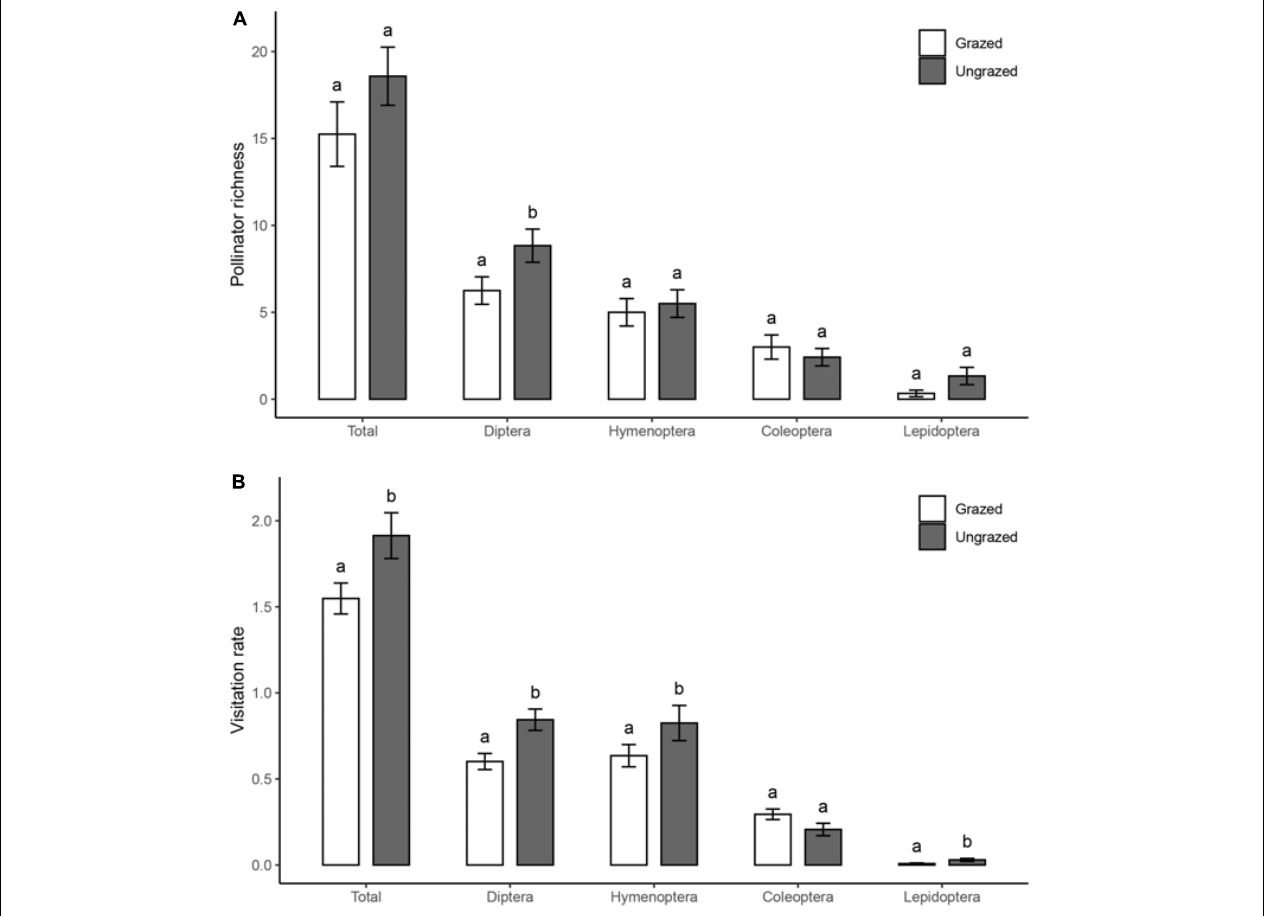
FIGURE 1 | (A) Number of total and of each order pollinator species ( n = 24 networks) in grazed and ungrazed habitats. (B) Visitation rate from total and of each order pollinators (based on data of the individual observation of each plant species in each network, n = 1,414). Bar plots show mean ± SE. White bars represent grazed habitats, and gray bars represent ungrazed habitats. Letters shown above the bar plots indicate the statistical difference between grazed and ungrazed habitats ( P = 0.05). Results from statistical models are given in Table 1A and Supplementary Table 1 .